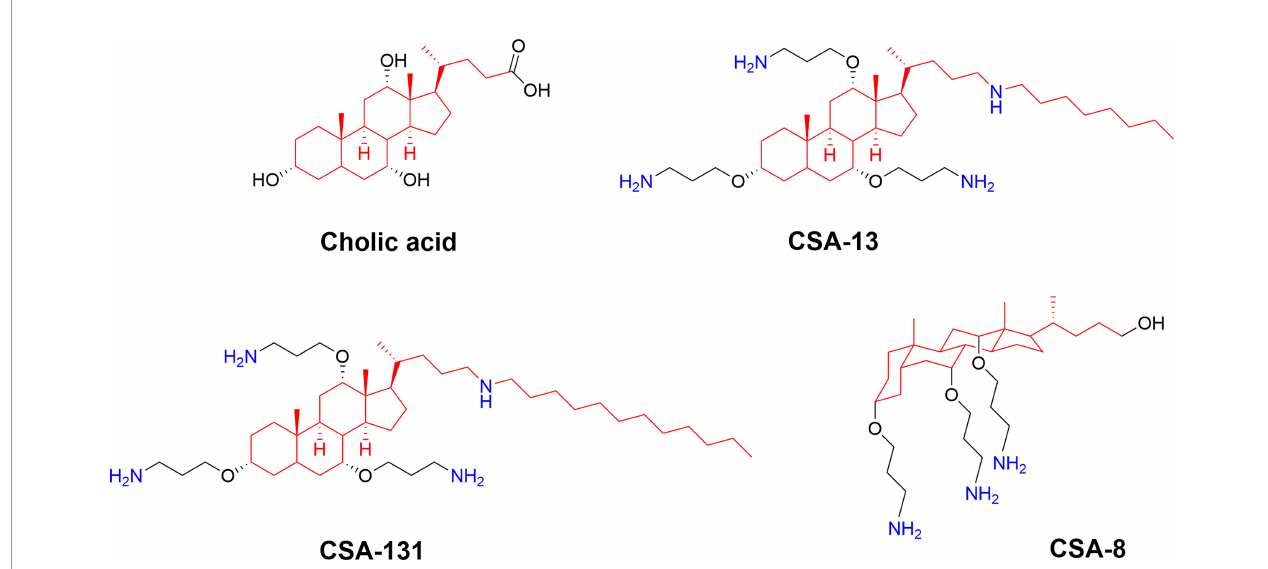
FIGURE 9 | Structures of natural cholic acid and examples of the ceragenins CSA-13, and CSA-131 incorporating amine and alkyl modi fi cation. The perspective drawing of CSA-8 illustrates the facial amphiphilicity of the fi nal compounds which is key for bioactivity